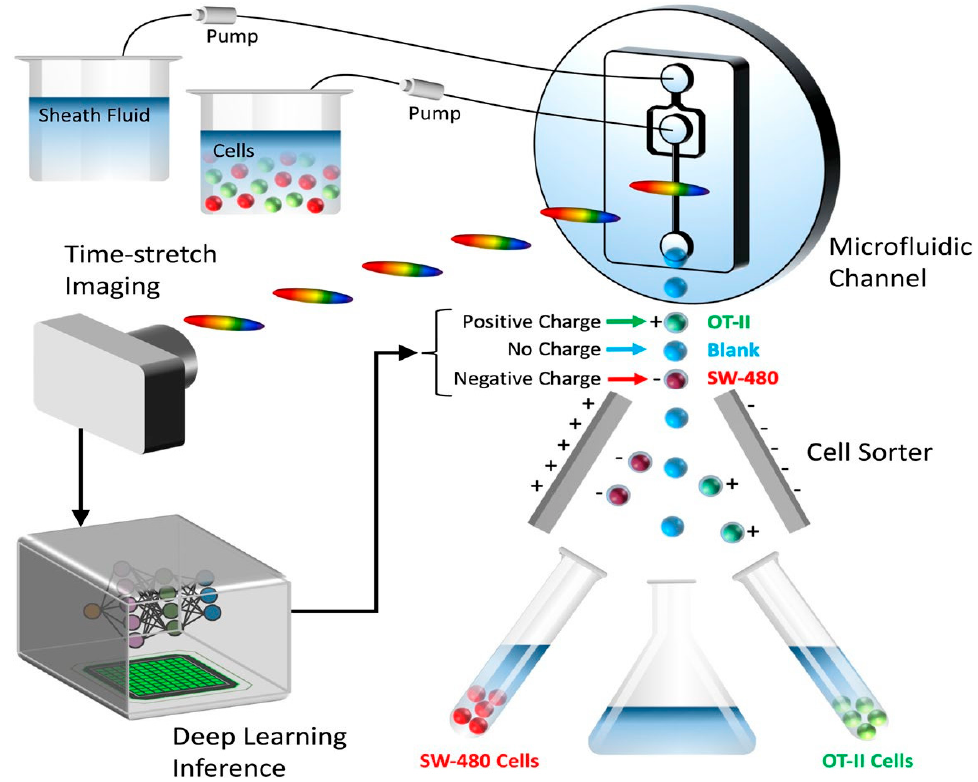
Figure 19 . The deep neural network recognizes cell types by their corresponding waveforms. Di ff erent types of cells are categorized and charged with di ff erent polarity charges so that they can be separated into di ff erent collection tubes. Reprinted with permission from [351]. Copyright 2019, Nature